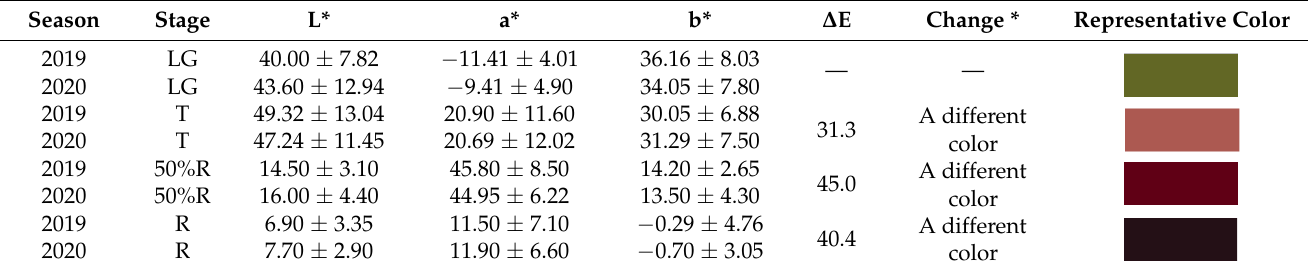
Table 2. Color readings of four stages of blackberry ( Rubus ulmifolius Schott) fruit skin.